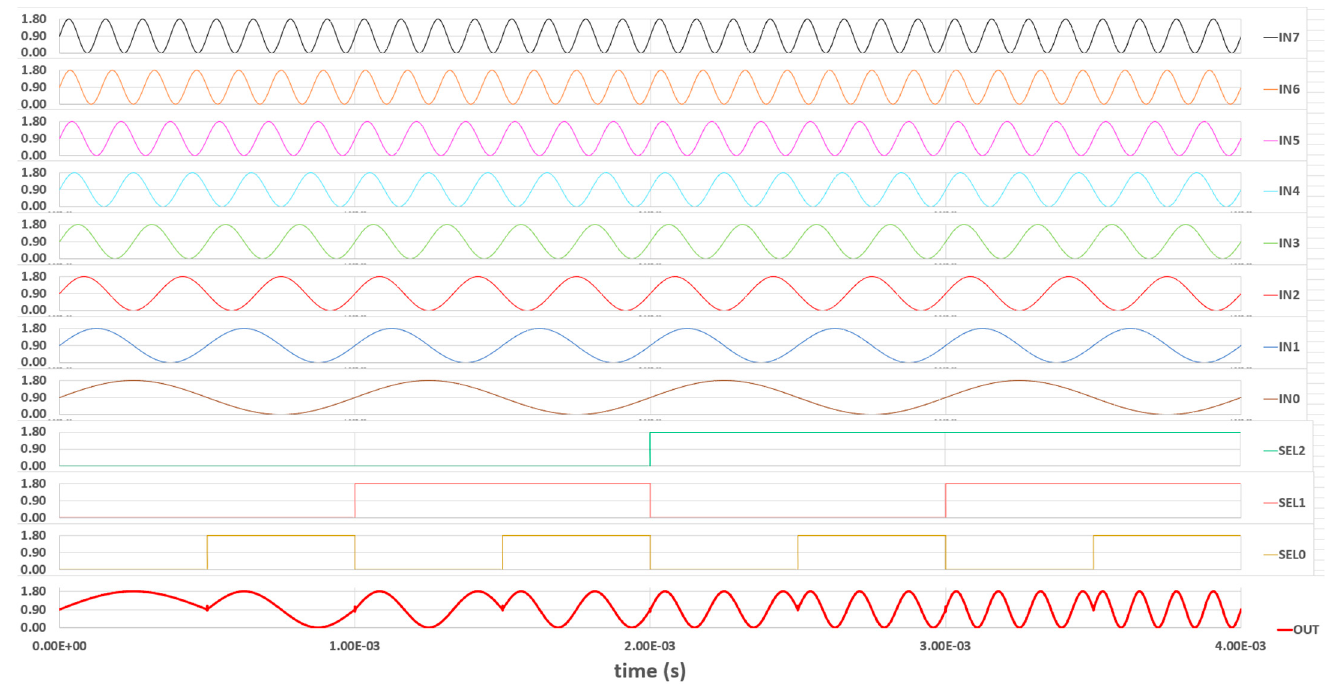
Figure 9. The 8:1 analog MUX post-layout